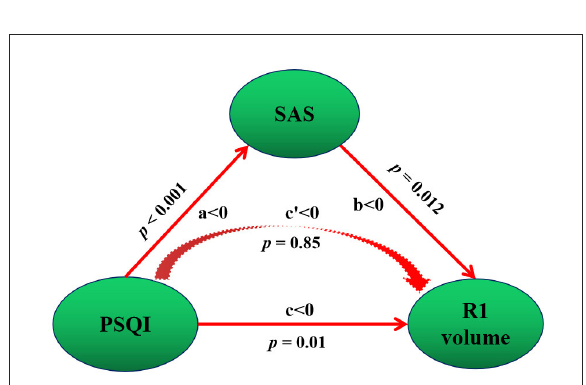
FIGURE2 Mediation association of post-insomnia negative emotion, insomnia severity, and hippocampal atrophy. Negative emotion refers to SAS. PSQI refers to insomnia severity. Total PSQI score was negatively correlated with R1 volume, which indicates a positive correlation with R1 volume atrophy. SAS score was negative acting in the causal path of PSQI leading to R1 volume, that is, SAS score was positive acting in the causal path of PSQI leading to R1 volume atrophy. Positive and negative mediation acting was determined by the value of c and c ′ . In our study, c ′ < 0, this means a negative mediation acting in the causal path of PSQI leading to R1 volume increase. This is, a positive acting in the causal path of insomnia severity (PSQI score) leading to R1 atrophy (negative c ′ < 0 and R1 volume increase = positive acting to R1 atrophy). a, the direct effect from PSQI to SAS; b, the direct effect from SAS to R1 volume; c, the direct effect from PSQI to R1 volume. p, p value for the mediation